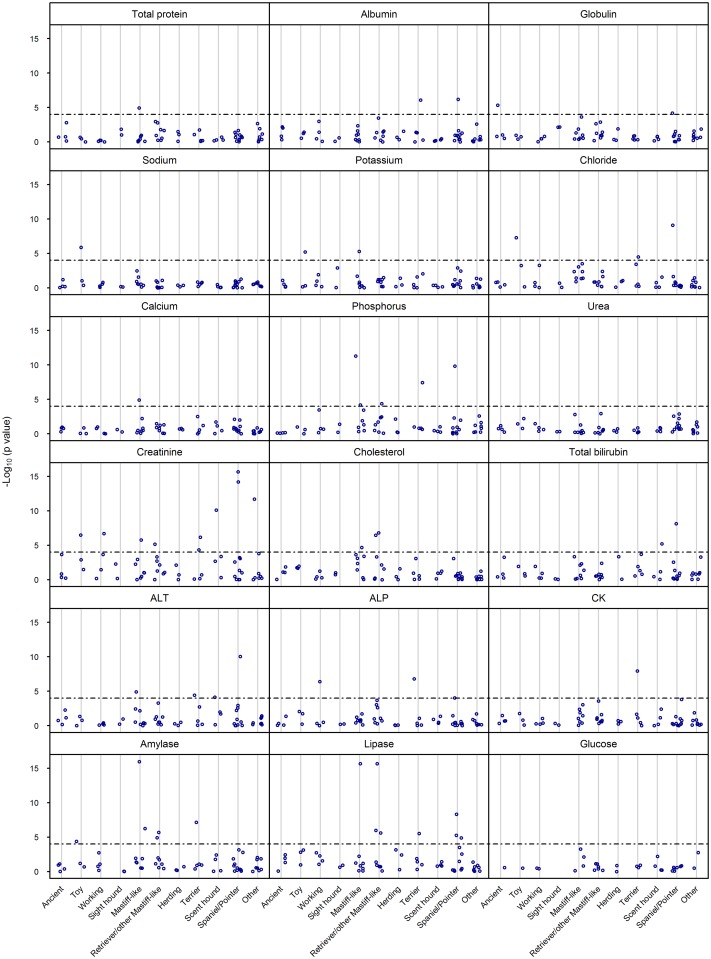
Pairwise comparisons of serum biochemical analytes between pure breed and mixed breed dogs confirm breed-specific phenotypes.The results of two-sample Kolmogorov-Smirnov tests to compare the distributions of residuals for the pure breed versus mixed breed dogs (Residuals were defined as the observed values minus the estimated fixed effects of age, sex and neutering status). Respective y axes show -log10 (p value) of specific individual breeds assigned to one of 11 genetically-related groups, shown on the x axes. A Bonferroni correction yielded a threshold for significance of 10−4, represented by the interrupted line. All breeds with residual values significantly different from those of the mixed breed population are shown above the line.